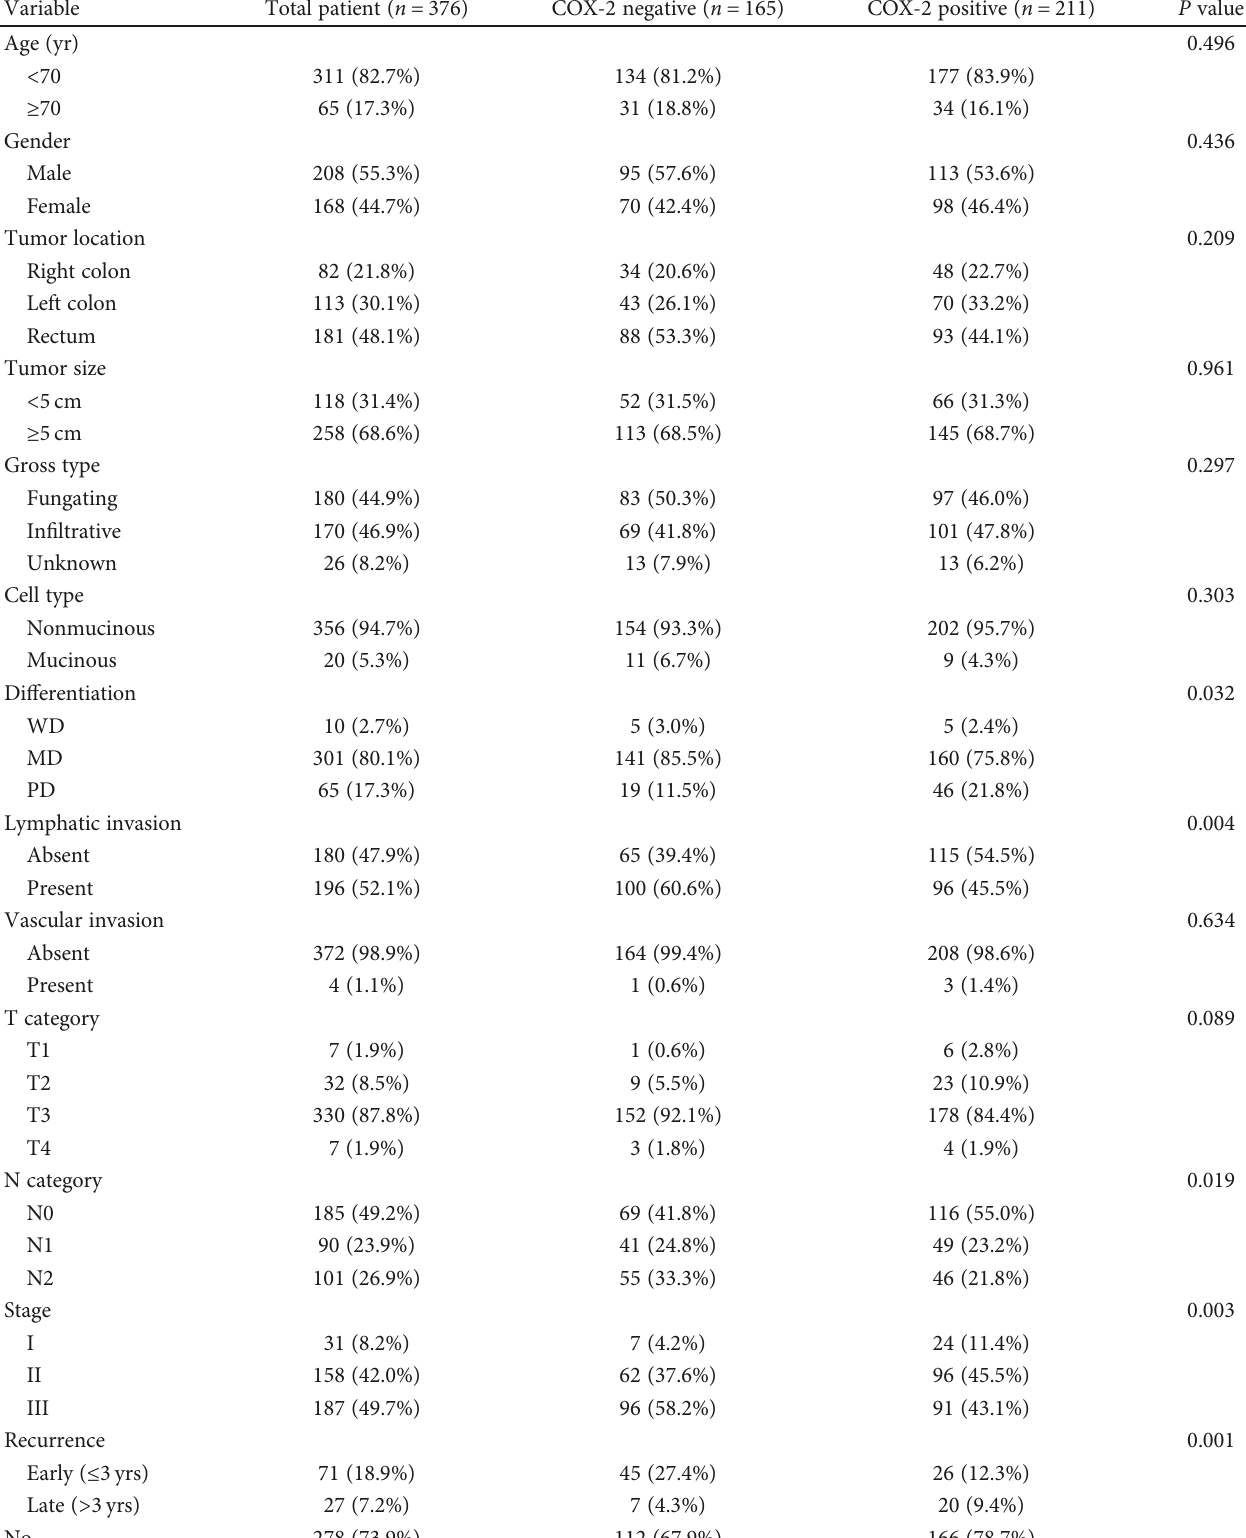
Table 1: Clinical and pathological characteristics according to COX-2 expression in 376 patients with R0